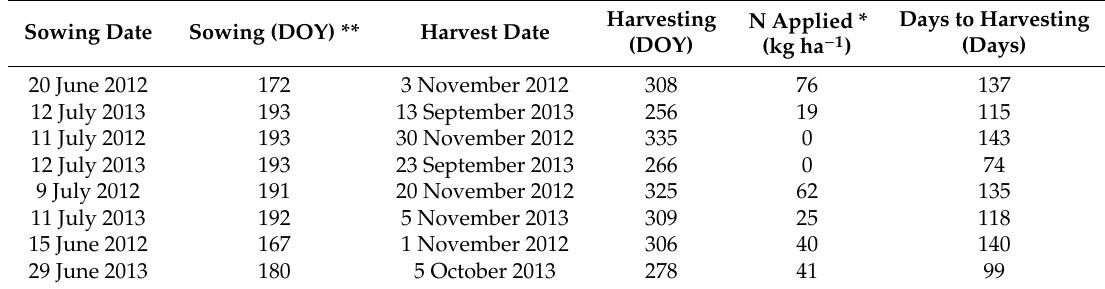
Table 2. Sowing date, harvesting date and fertilizer amount applied by the farmers in West Mamprusi